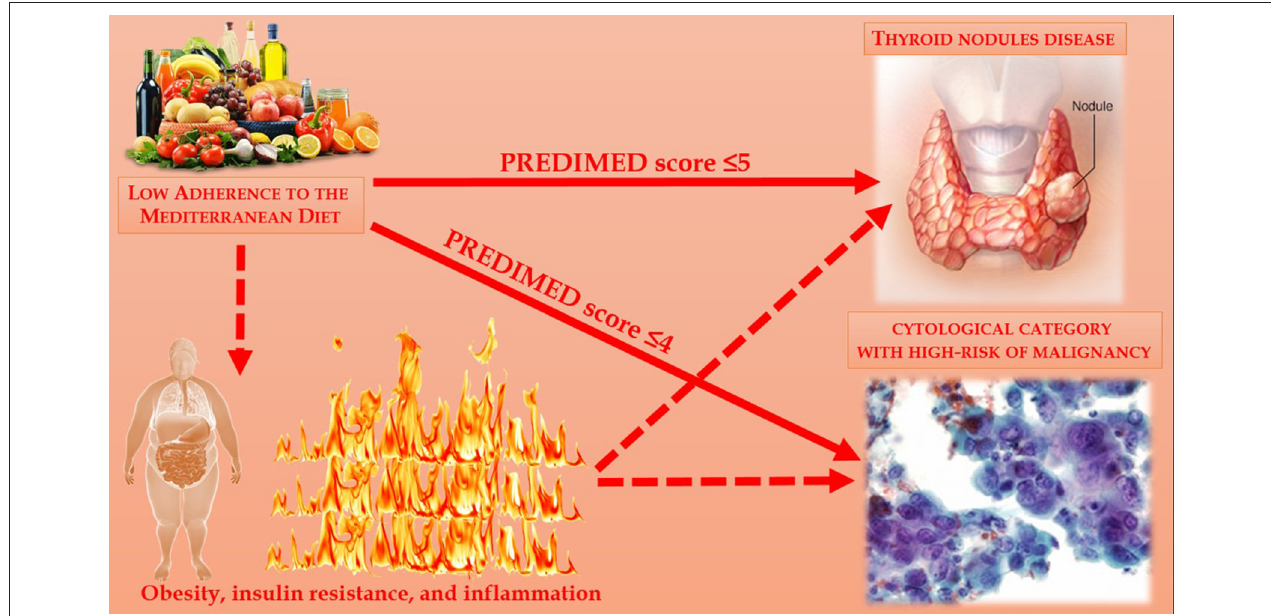
FIGURE 4 | Association between adherence to the MD and thyroid nodular disease and cytological category with high-risk of malignancy were carried out.